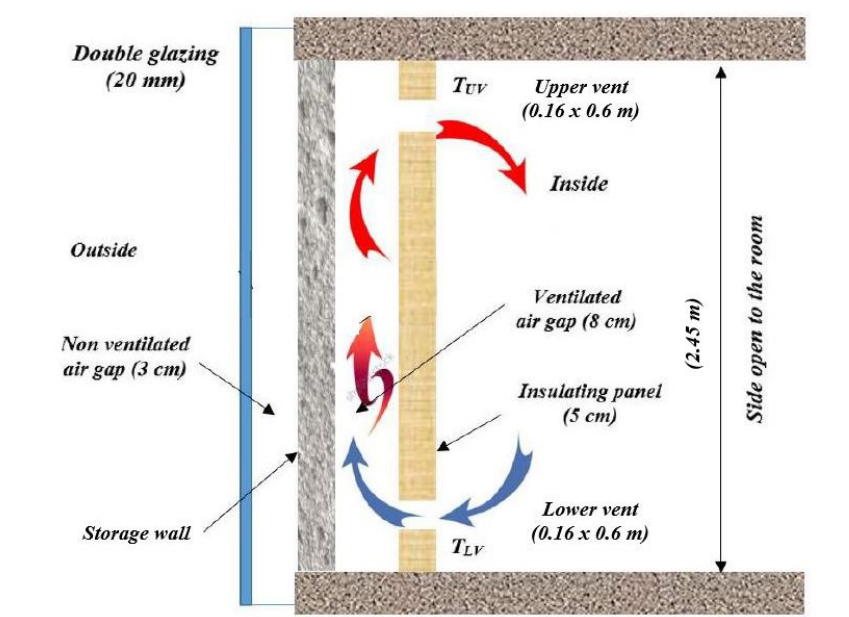
Figure 3. Vertical cross-section of the composite Trombe